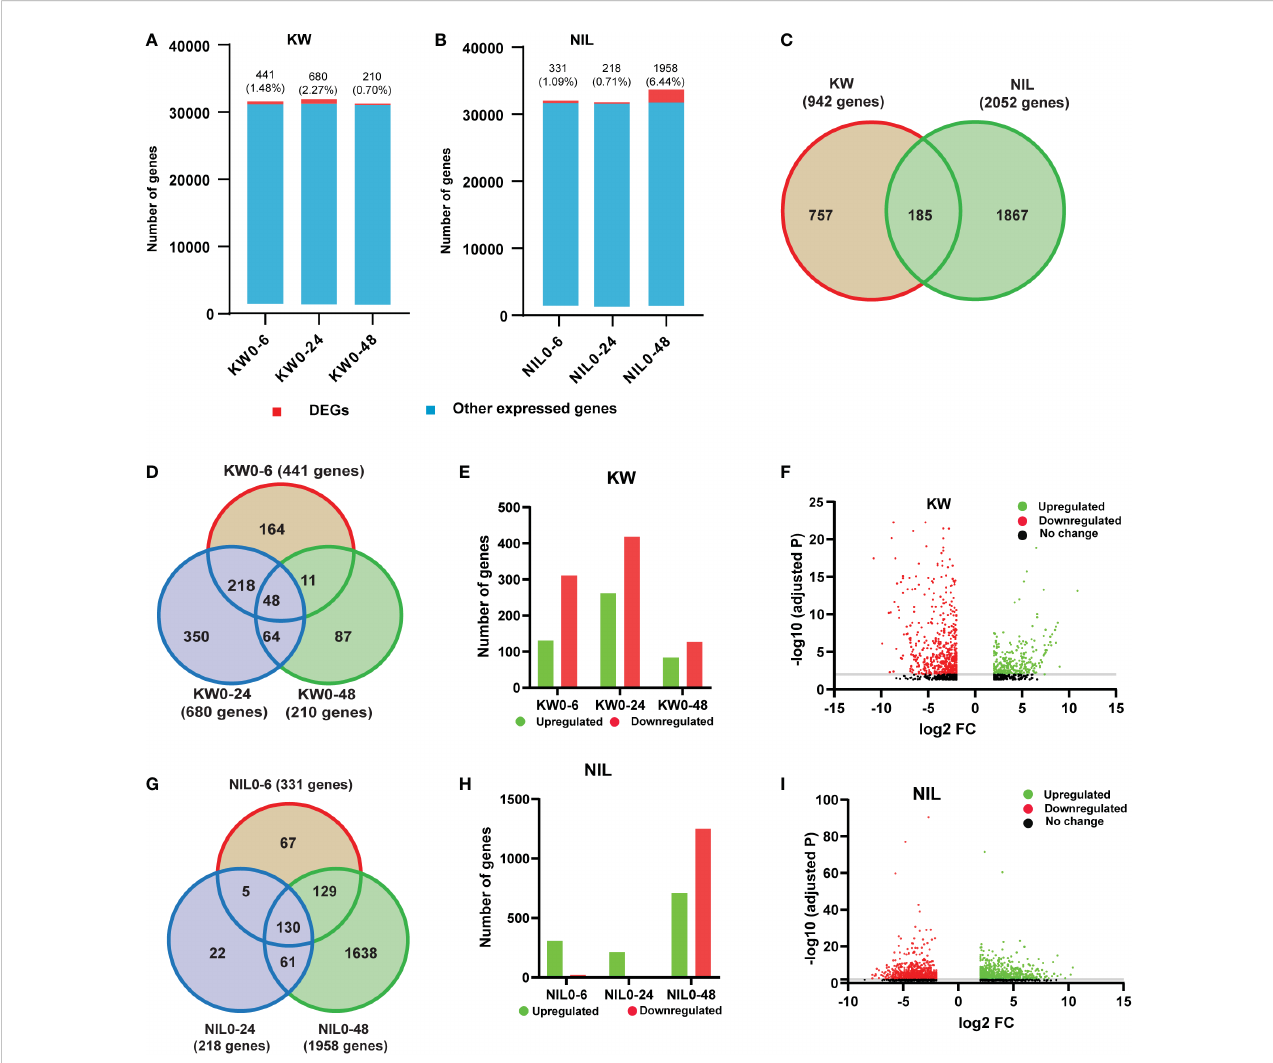
FIGURE 1 Comparison of differentially expressed genes (DEGs) in Kangwenqingzhan (KW) and its NIL under 6h, 24h, and 48h. (A) Proportionate percentages of DEGs to other expressed genes, red color in the bar graph shows the proportion of DEGs to other expressed genes illustrated in blue color for KW. (B) Proportionate percentages of DEGs to other expressed genes, red color in the bar graph shows the proportion of DEGs to other expressed genes illustrated in blue color for NIL. (C) Venn diagram depicts unique and overlapped DEGs among KW and NIL. (D) Venn diagram describing total, unique, and overlaps among DEGs after three treatments for KW, the number of shared DEGs is speci fi ed in circles. (E) Bars represent the distribution of up and downregulated DEGs in KW. (F) Volcano plot representing up and downregulated DEGs for KW. (G) Venn diagram describing total, unique, and overlaps among DEGs after three treatments for NIL, the number of shared DEGs is speci fi ed in circles. (H) Bars represent the distribution of up and downregulated DEGs in NIL. (I) Volcano plot representing up and downregulated DEGs for